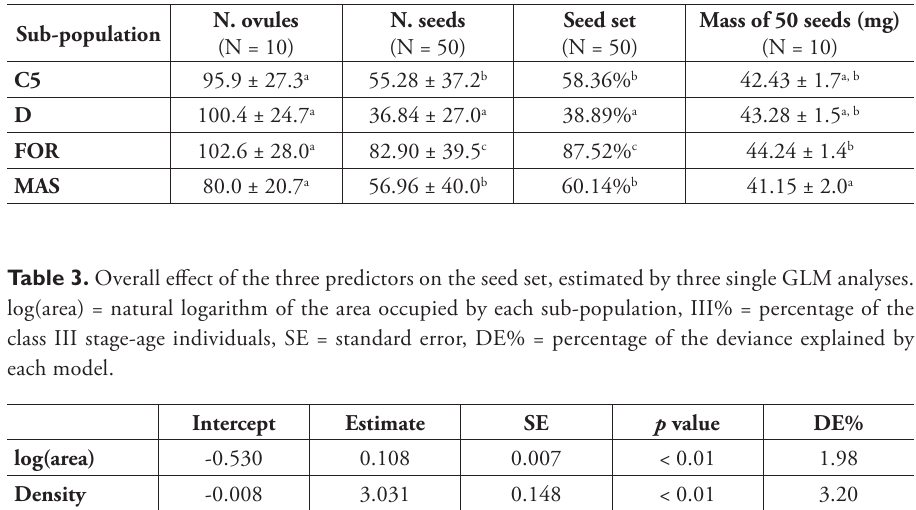
Table 2. Reproductive features of the Italian population of C. laurifolius subsp. laurifolius . For each sub- population, mean values and standard deviations are reported. Different letters indicate growing ranking significant differences amongst groups (ANOVA test for ovule number, seed number and seed mass; χ 2 test for seed set).